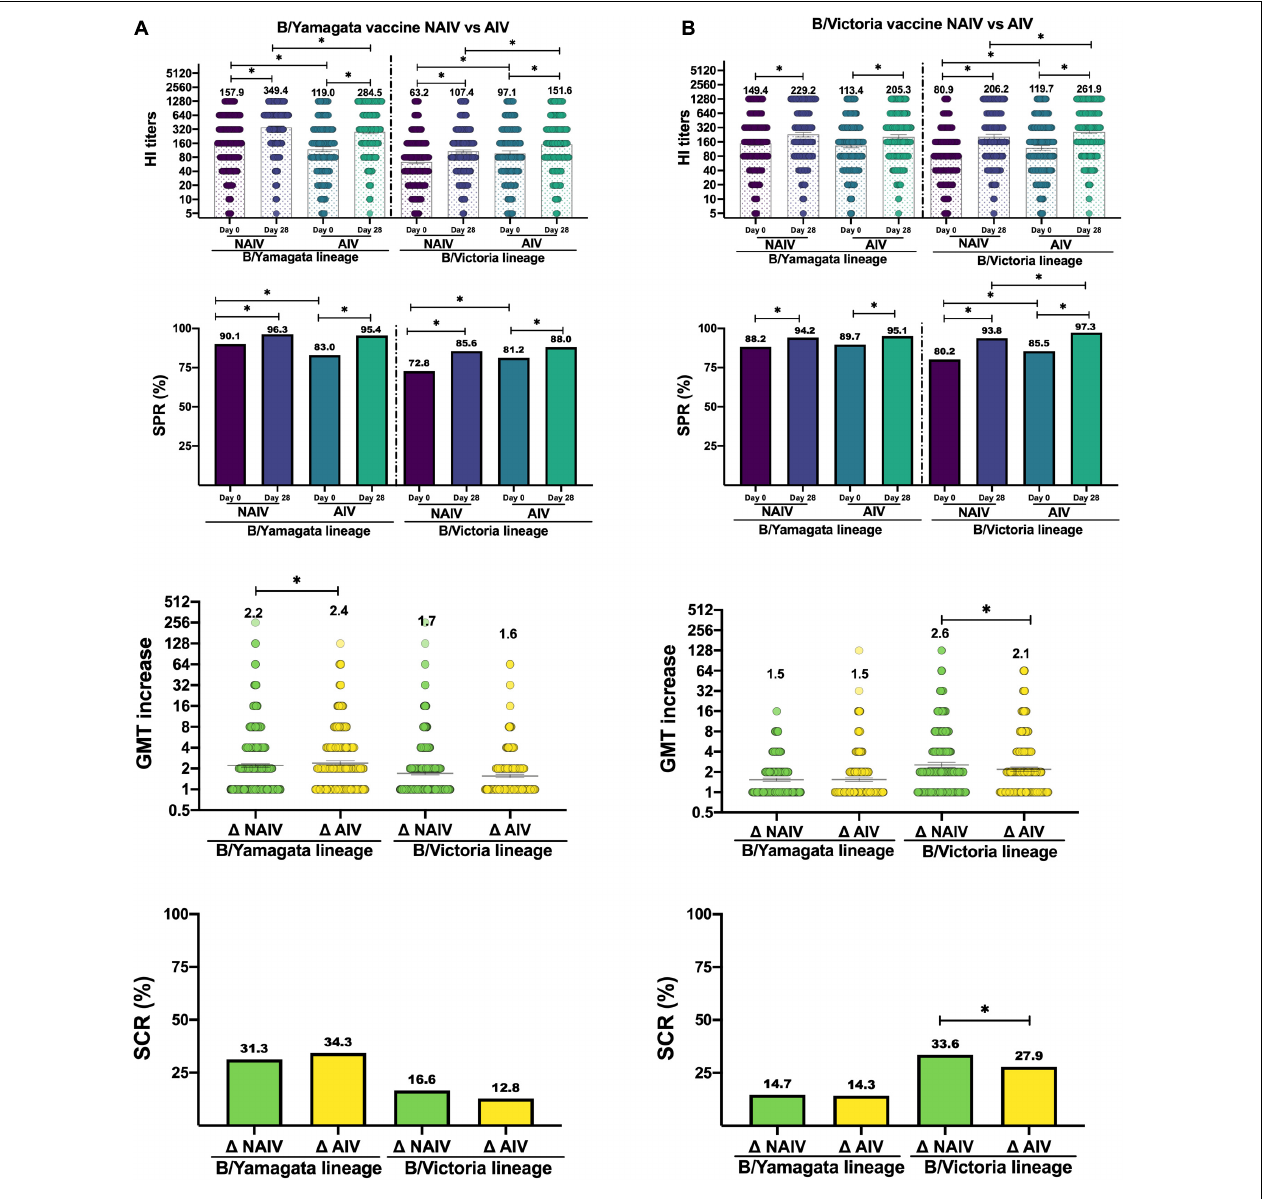
FIGURE 2 | Values of hemagglutination titers, seroprotection rate (SPR), GMT increase (GMTi) and seroconversion rate (SCR). (A) Response to B/Yamagata vaccine by type of vaccine. (B) Response to B/Victoria vaccine by type of vaccine. Significant differences ( p < 0.05) are marked with ∗ .